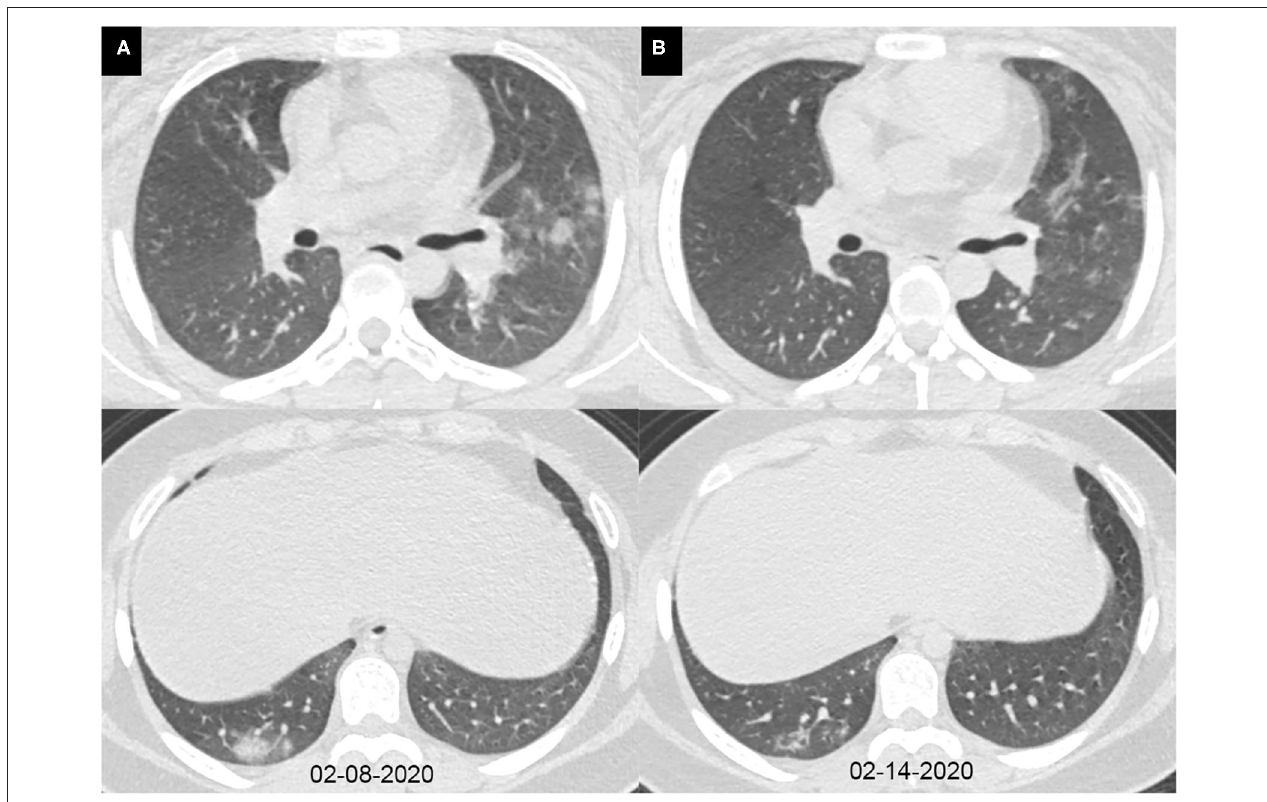
FIGURE 4 | Axial chest CT images of a 15-year-old girl with fever, cough, diarrhea, and headache for 7 days. Pharyngeal swab RT-PCR tests were performed on February 12, 2020, with positive results, and on February 15 and 17, 2020, with negative results. Chest CTs were obtained on February 8 (A) and 14, 2020 (B) . (A) The subpleural consolidations and nodules were seen in the right lower lobe and the left upper lobe. (B) The consolidations and nodules were obviously absorbed.